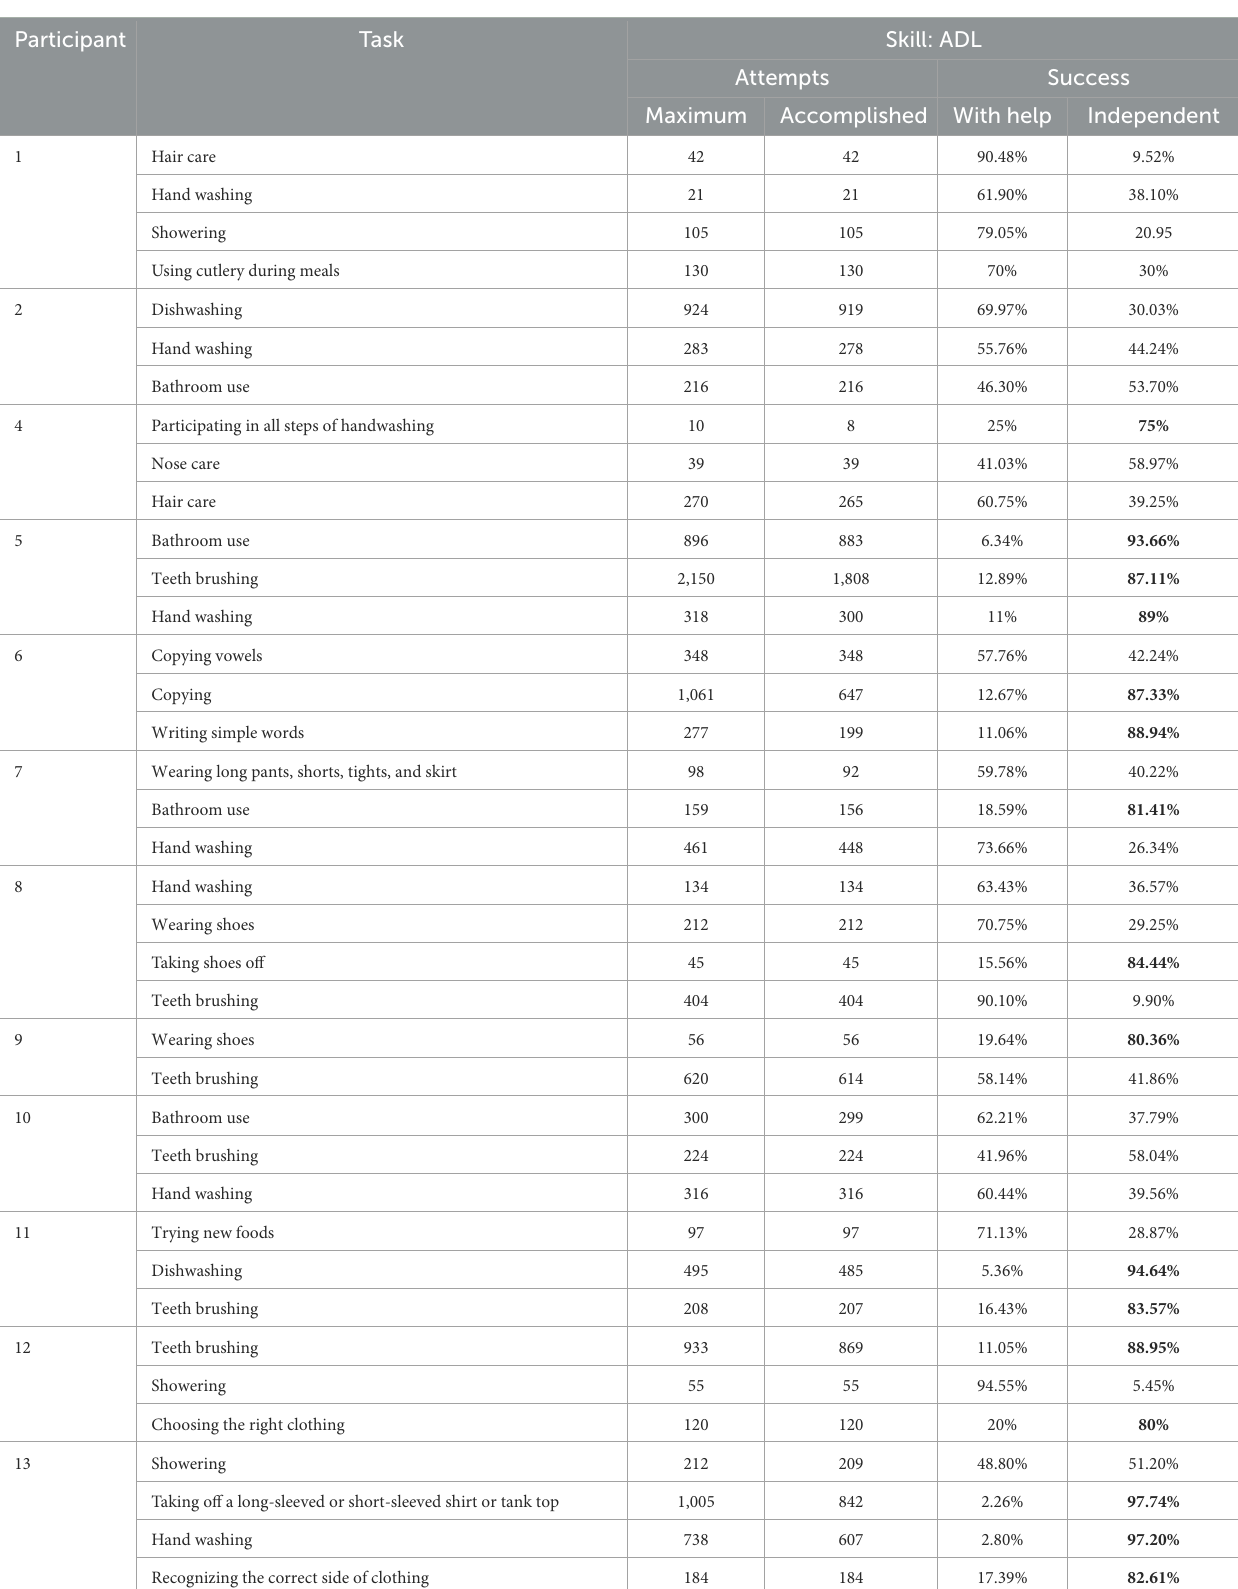
TABLE 4 Participant’s task training results for ADL